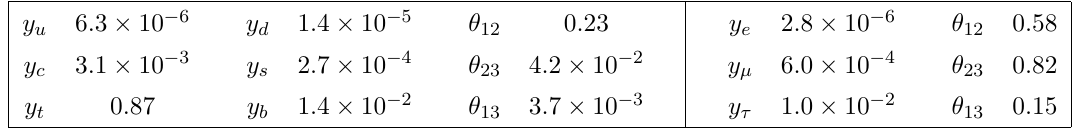
Table 1 . Quark and Lepton data at 1 TeV in the SM